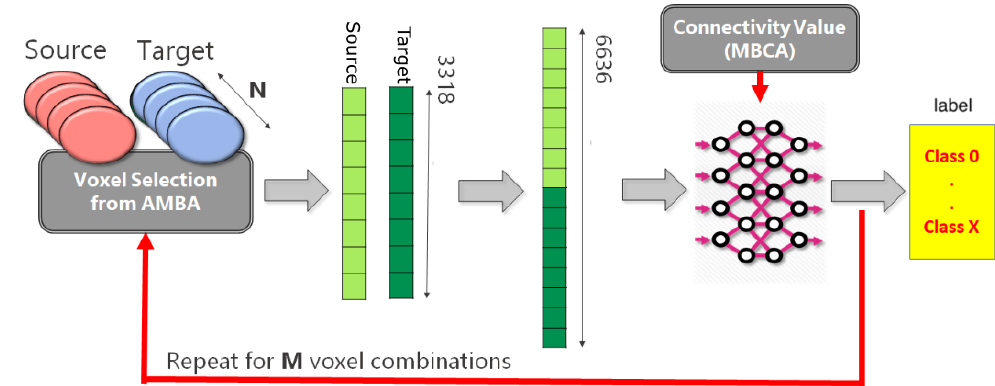
Figure 1. Scheme of the analysis pipeline. For each Source-Target pair ( N , in total), we randomly select M voxel combinations. Per each combination, we generate two 3318 gene expression vectors (Source and Target, respectively) with information taken from Allen Mouse Brain Atlas